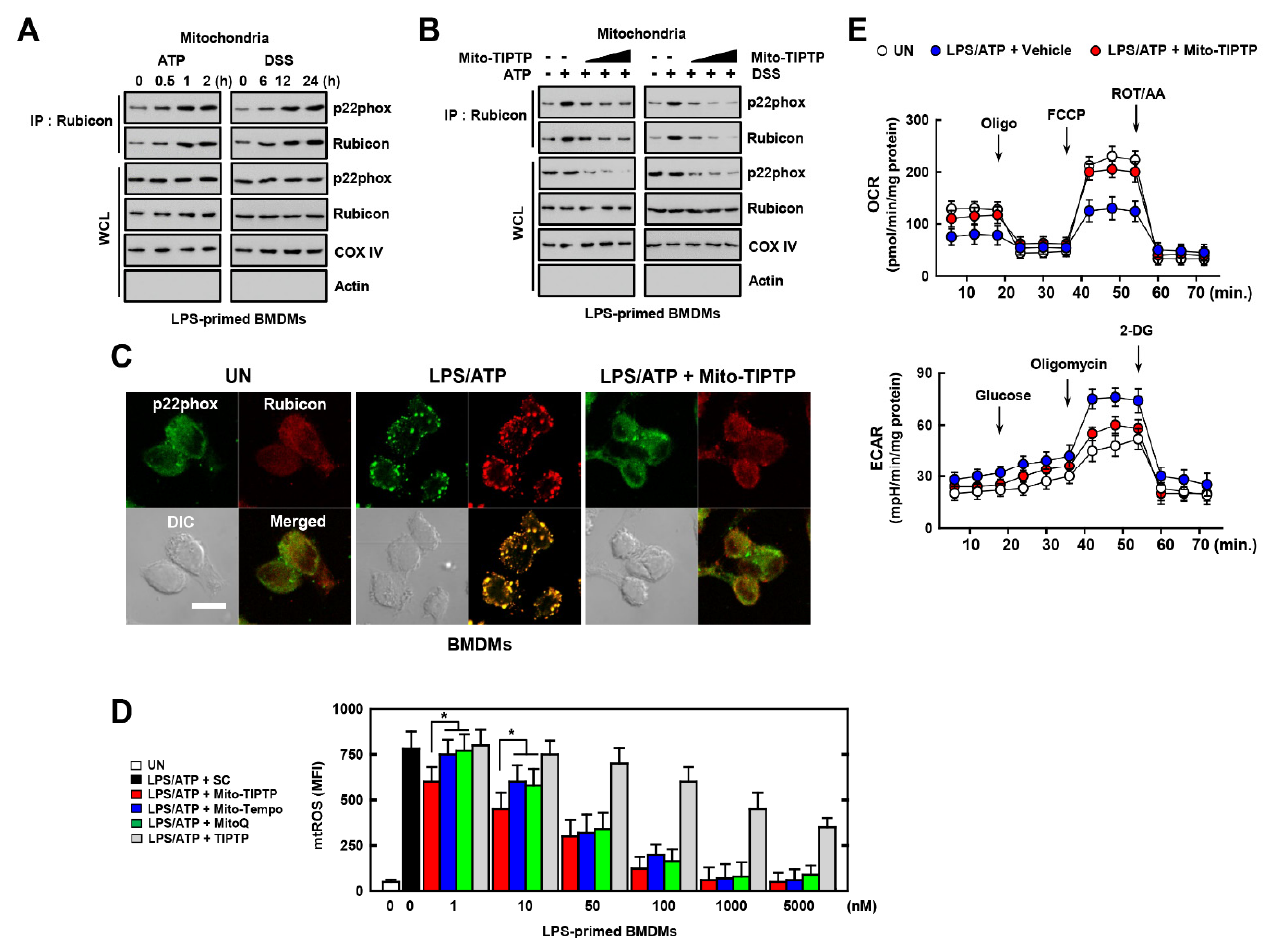
Figure 5. Effects of Mito − TIPTP in mitochondrial functions. BMDMs were mitochondria fractionated by Mitochondria Isolation Kit. ( A ) LPS (100 ng/mL)-primed mitochondria fractionated − BMDMs were activated with ATP (1 mM) for 30 min or DSS (3%) for 18 h, and subjected to IP with α Rubicon. IB with α p22phox and α Rubicon. WCLs were